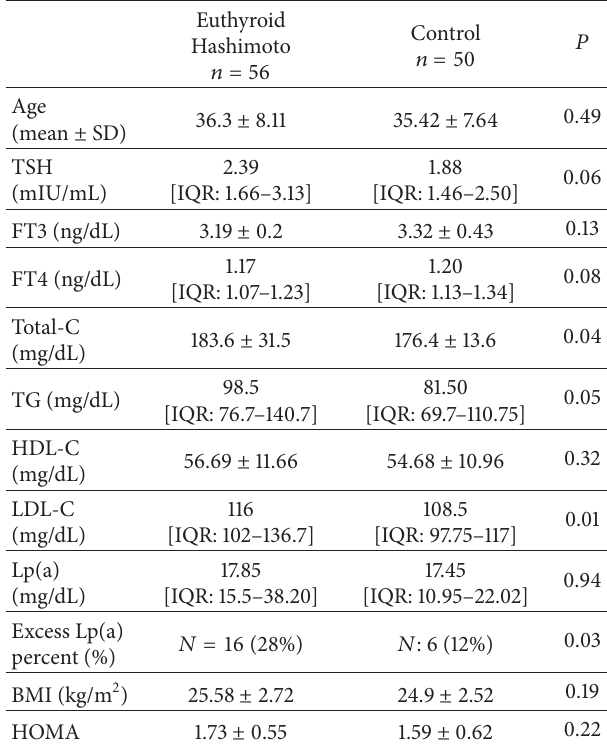
Table 3: Demographic and laboratory results of the subclinical hypothyroid and the control